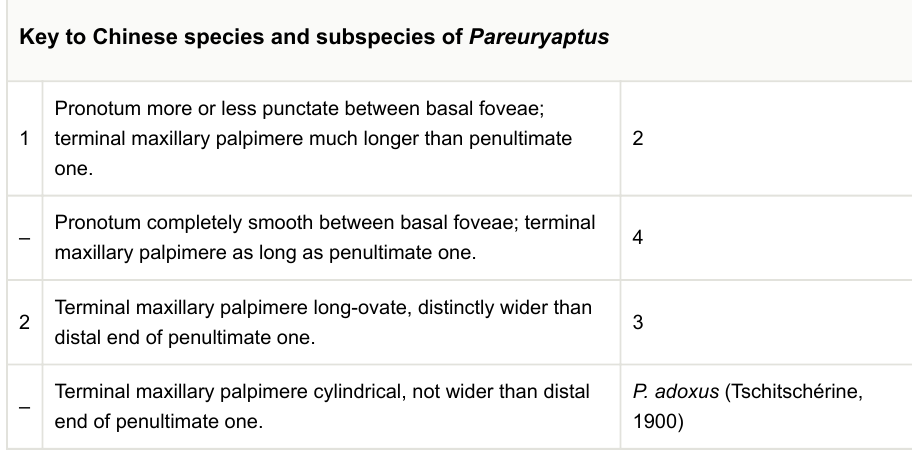
Habitus: Fig. 1f. Maxillary palpus: Fig. 3f. Pronotum: Fig. 4d. Body length = 11.7 mm. Dorsal surface black. Similar to the nominal-typical subspecies, but different in the pronotum being only sparsely punctate between basal